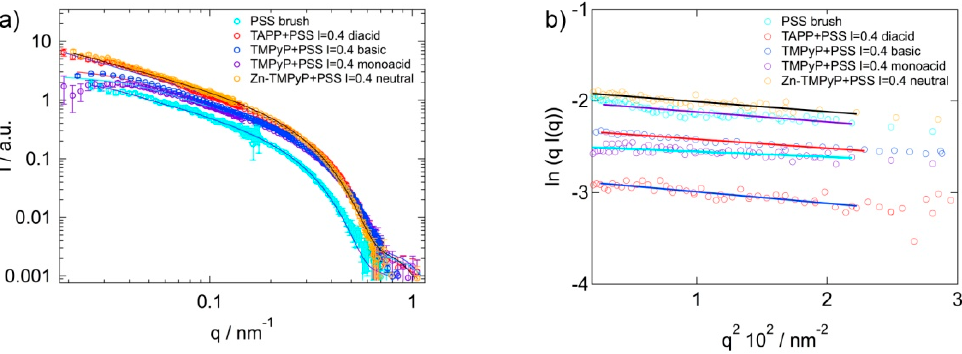
Figure 2. Small angle neutron scattering of PSS brush and different porphyrins: ( a ) scattering curves I(q); ( b ) cross-section Guinier plot. Straight lines reflect the corresponding fit. Table 1. Cylinder lengths, cross-section radii and radii from SANS data.